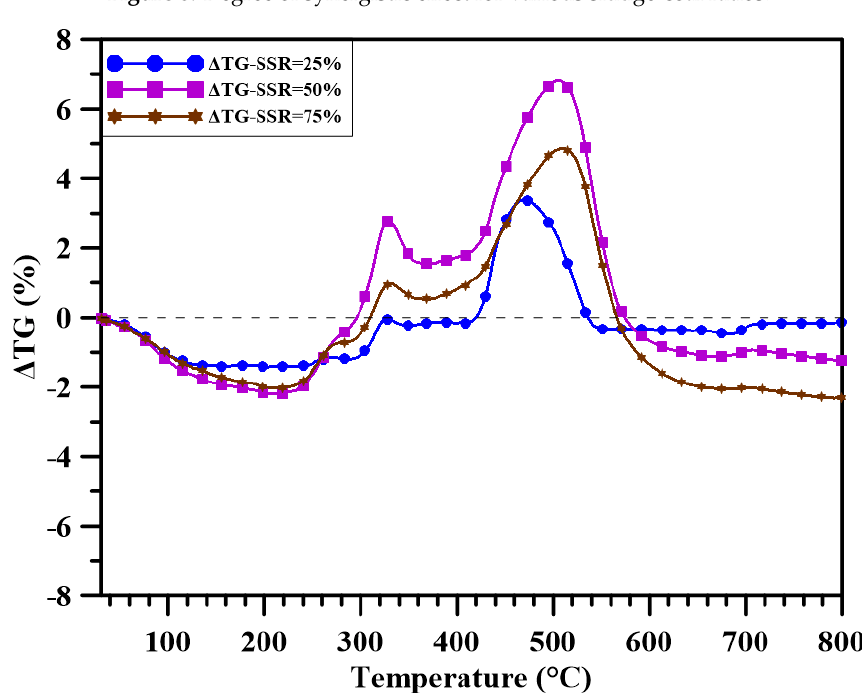
Figure 9. Degree of synergistic effect for various sludge-shiitake ratios.